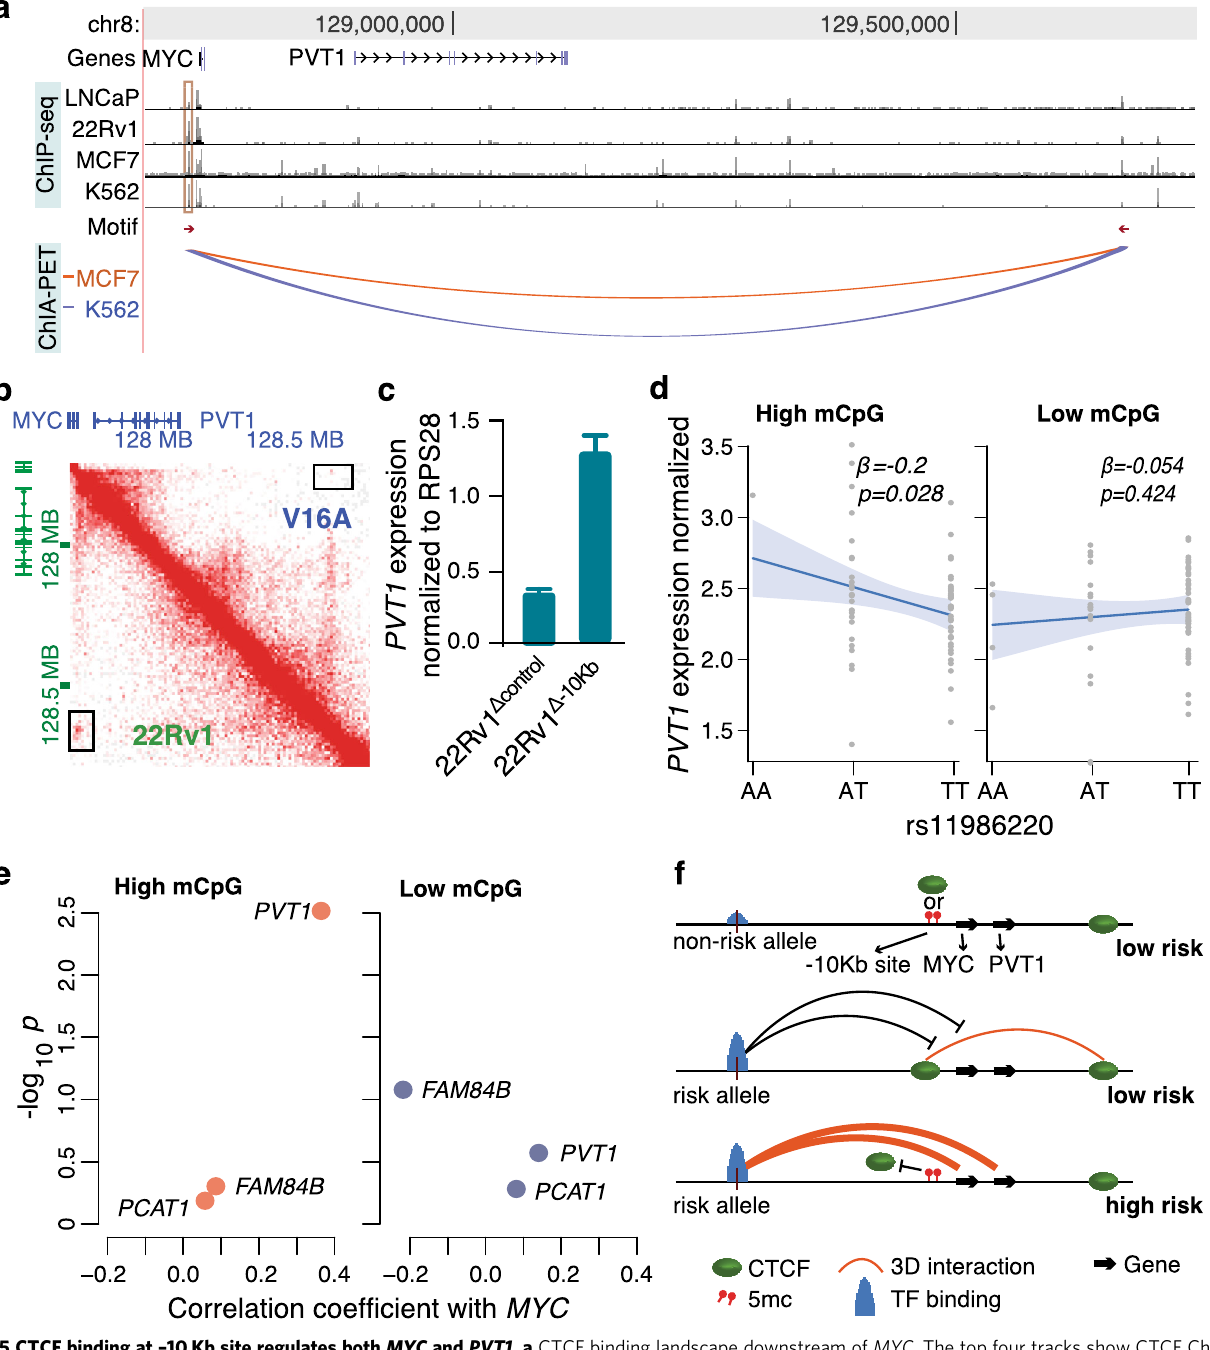
Fig. 5 CTCF binding at – 10 Kb site regulates both MYC and PVT1 . a CTCF binding landscape downstream of MYC . The top four tracks show CTCF ChIP- seq signals in four cancer cell lines. The – 10 Kb site is highlighted in red. The motif track shows a canonical CTCF-binding motif. The direction of the arrow indicates the orientation of the motif. The arcs show CTCF interactions between two CTCF binding sites in two cell lines as determined by ENCODE CTCF ChIA-PET data. b The Hi-C interaction map in V16A (top right triangle) and 22Rv1 (bottom left triangle) cells in this region. The interaction point in black rectangle denotes the interaction between two CTCF sites as shown in panel ( a ). c Quanti fi cation of PVT1 expression in 22Rv1 cells upon deletion of – 10 Kb site by CRISPR/Cas9. Error bars denote standard error of mean ( n = 2). P value is estimated using t test. d Association between rs11986220 genotype and PVT1 expression in prostate tissues dichotomized by high (left panel) and low (right panel) level of methylation of the CpG in CTCF binding motif at – 10 Kb site. The lines indicate the best fi t for the regression models and the shaded areas indicate 95% con fi dence interval. The regression coef fi cient, β , and the p value are calculated using linear regression analysis. e Pearson ’ s correlation coef fi cient between the expression of MYC and neighboring genes in prostate tissues dichotomized by the methylation level of the CpG. See Supplementary Fig. 5a for expression of neighboring genes. f Schematic of regulation of causal mechanism by methylation-dependent CTCF binding at – 10 Kb site. Source data are provided as a Source Data fi le.